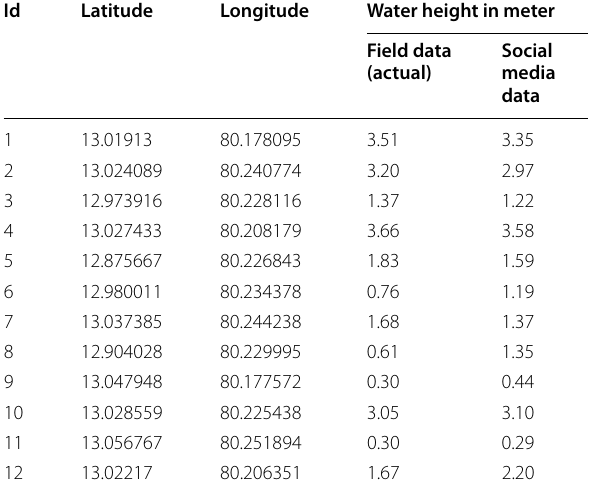
Table 1 Comparison of field data and derived data from social media (Water heights)